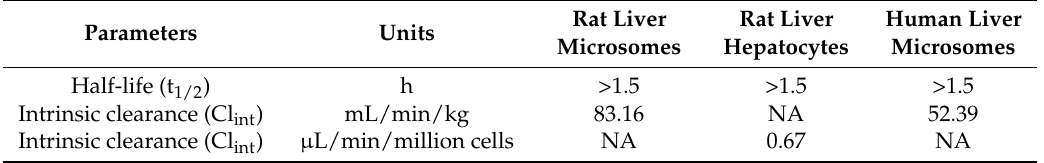
Table 4. Rat liver microsomes and hepatocytes and human liver microsome stability of eurycomanone. Parameters